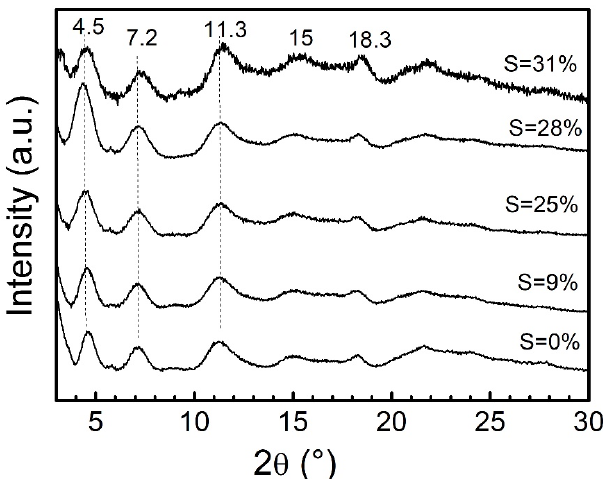
Figure 4. WAXD patterns (CuK α wavelength) of unsulfonated and sulfonated aerogels with different sulfonation degrees.